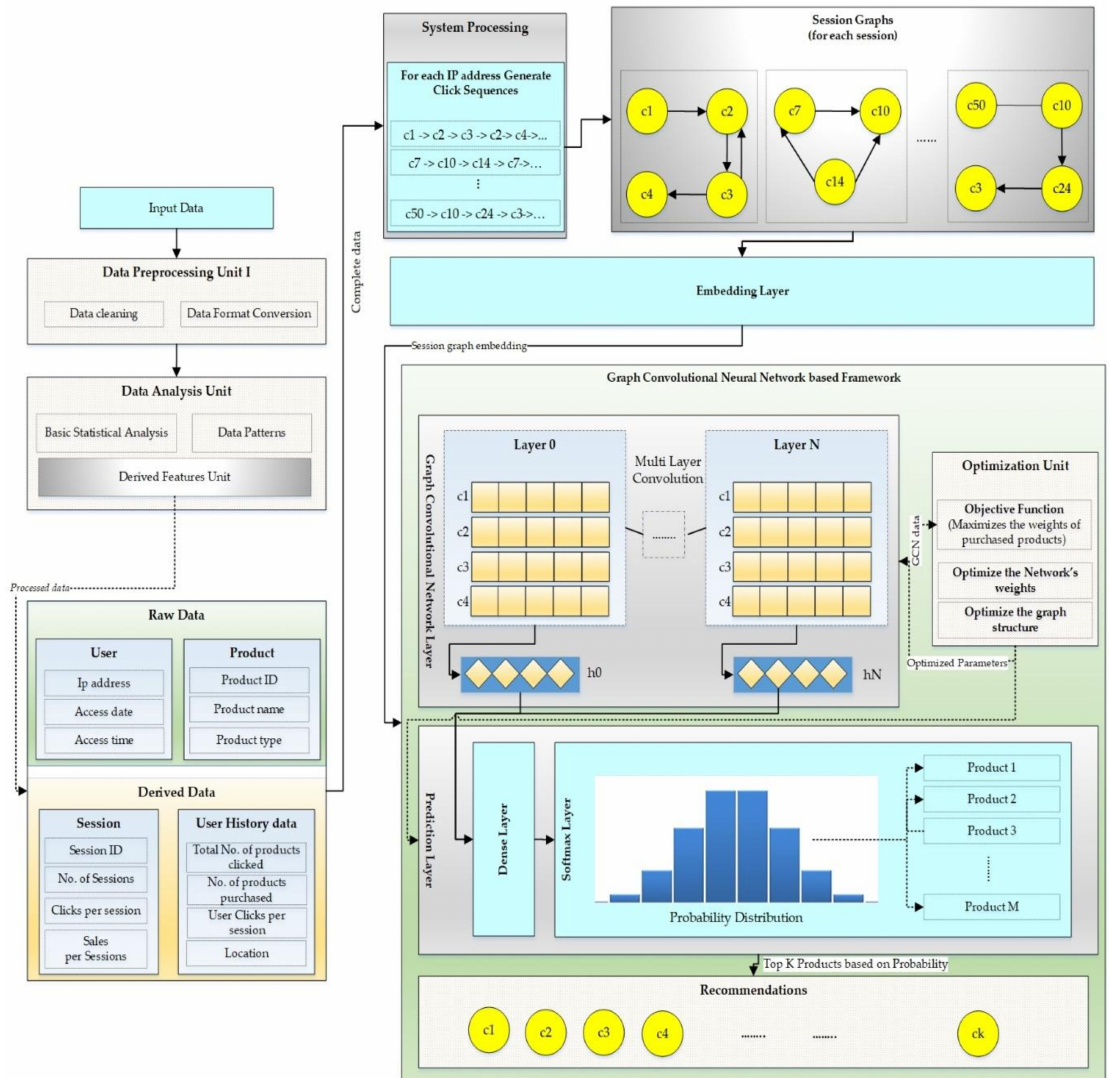
Figure 3. Proposed system